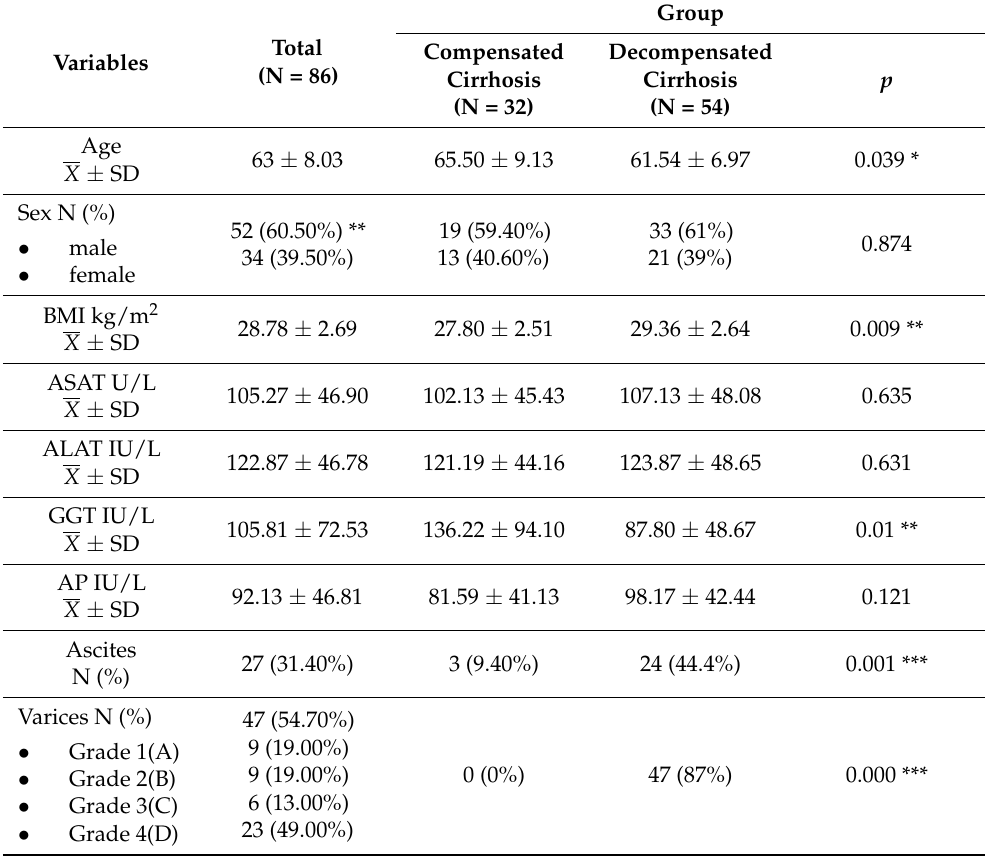
Table 2. General demographic and lab data.